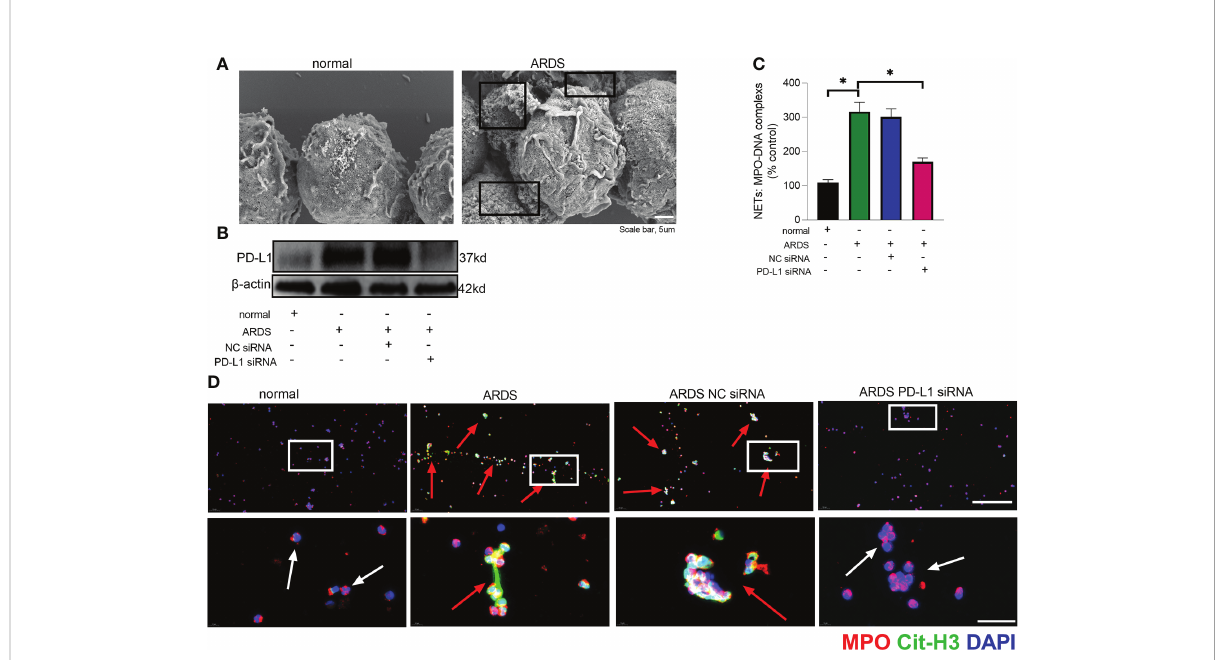
FIGURE 3 Down-regulated PD-L1 of neutrophils reduces NET release in human. (A) Representative scanning electron micrographs of neutrophil NET of normal and ARDS patients (scale bar: 5um). (B) Genetic silencing of PD-L1 using siRNA in ARDS neutrophils for 21 hours signi fi cantly decreased PD-L1 expression. (C) MPO-DNA complex measured in NETs structures in neutrophils culture supernatant. (D) Representative immuno fl uorescence images of Cit-H3 (green) and MPO (red) staining with blue DAPI nuclear staining in neutrophils. Neutrophils express MPO (red) and NET forming neutrophils also express Cit-H3 (green). Cyan fl uorescence represents the colocalization of Cit-H3 with DNA. The white arrowheads point to neutrophils not making NETs and the red arrows to neutrophils making NETs. The scale bar indicates 50 m m. Higher magni fi cation images are shown lower row of fi gures – scale bars indicate 10 m m. The values presented are mean ± SEM (n=6; *P<0.05, one- way analysis of